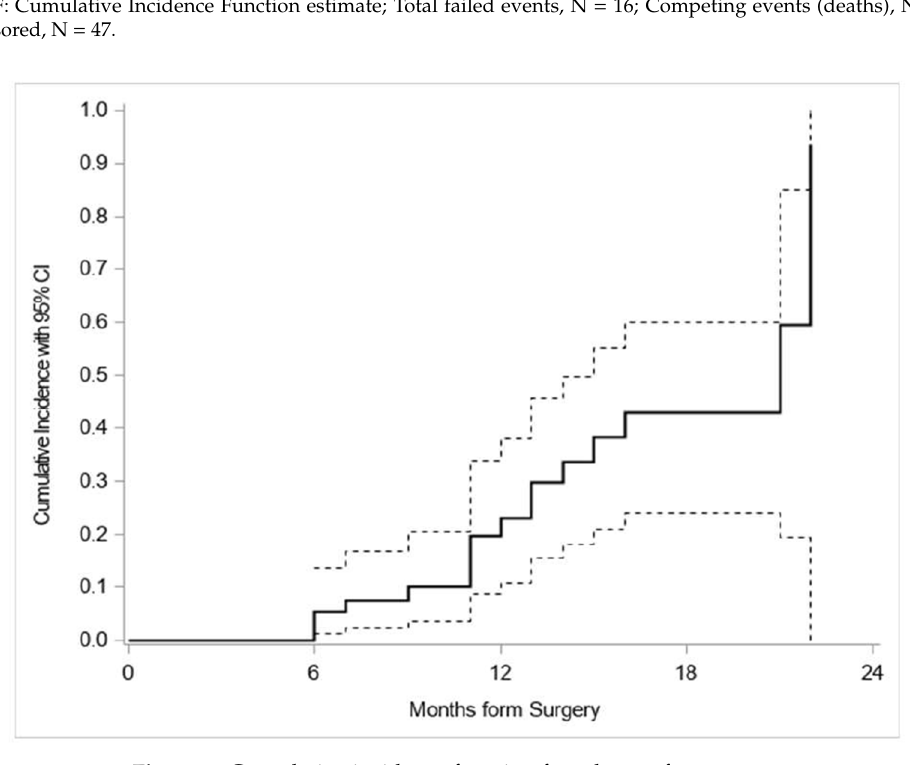
Figure 1. Cumulative incidence function for relapse after surgery.